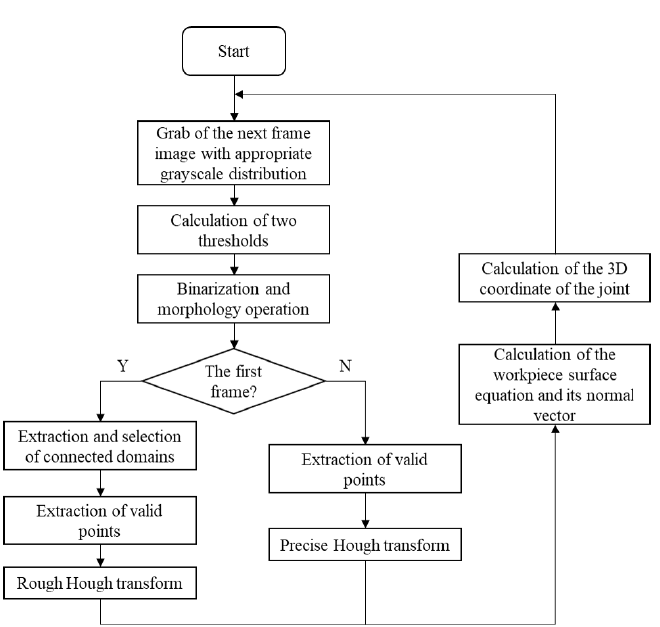
Figure 2. Flowchart of the proposed joint detection method.